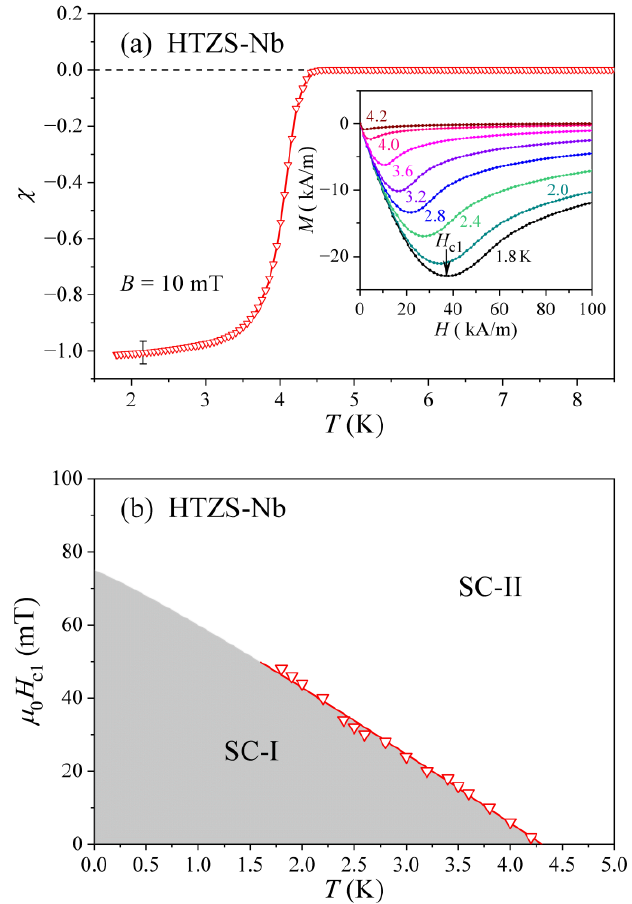
Figure 9. ( a ) Zero-field-cooled magnetic susceptibility χ of the HTZS-Nb alloy in a low magnetic field µ 0 H = 10 mT in the region of the superconducting transition. The inset shows isothermal magnetization M ( H ) at different temperatures, with the arrow denoting the lower critical field H c 1 at T = 1.8 K. ( b ) The temperature-dependent lower critical field H c 1 ( T ) (SC-I–superconducting region, SC-II–mixed (vortex) state).